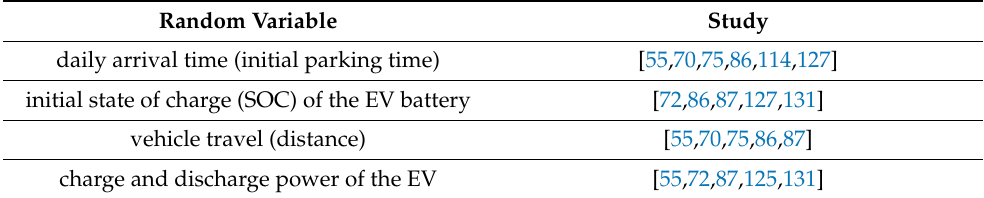
Table 6. Random Variables Concerning